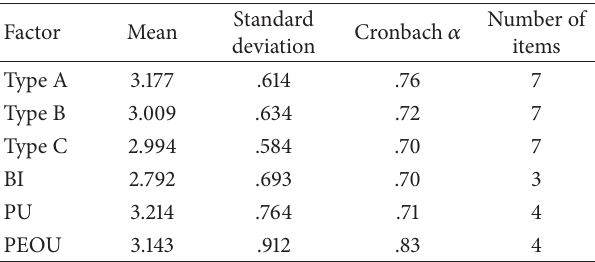
Table 4: Designer reliability and descriptive